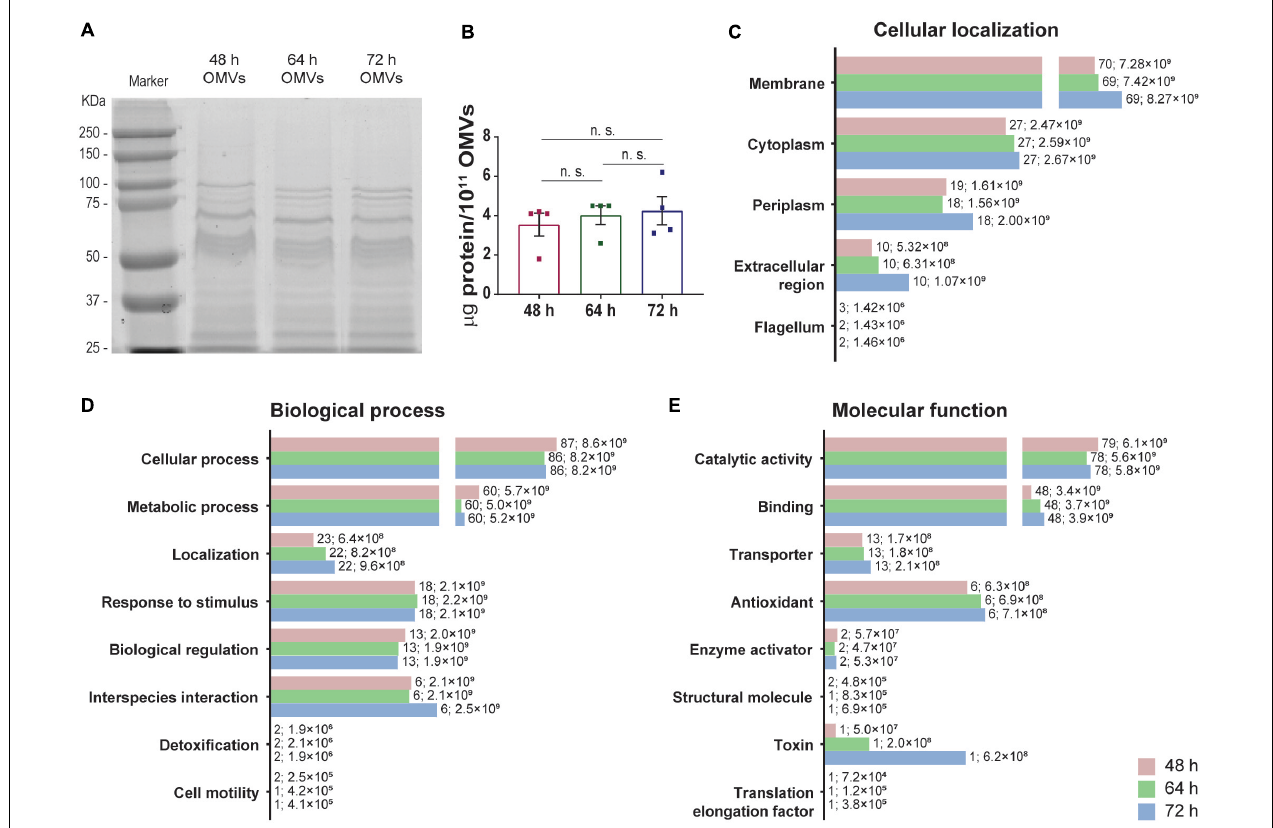
FIGURE 4 | Protein profile and proteomic analysis of OMVs secreted by Helicobacter pylori grown in F12-cholesterol medium. (A) Protein profile of 10 11 OMVs isolated from 48, 64, and 72 h- H. pylori 26695 bacterial cultures, after staining a SDS-PAGE with BlueSafe, and corresponding (B) protein quantification. Data are shown as mean ± SEM of four biological replicates and statistical significance was evaluated using the one-way ANOVA with post hoc Tukey’s test; n.s. – not significant. Proteomic analysis of 48, 64, and 72 h-OMVs isolated from H. pylori 26695 F12-cholesterol liquid cultures by nanoLC-MS/MS and prediction of the (C) cellular localization, (D) biological process, and (E) molecular function of the identified proteins using the gene ontology UniProt database. Data are shown as the abundance of proteins in each group; for each bar, the number of proteins and respective abundance is